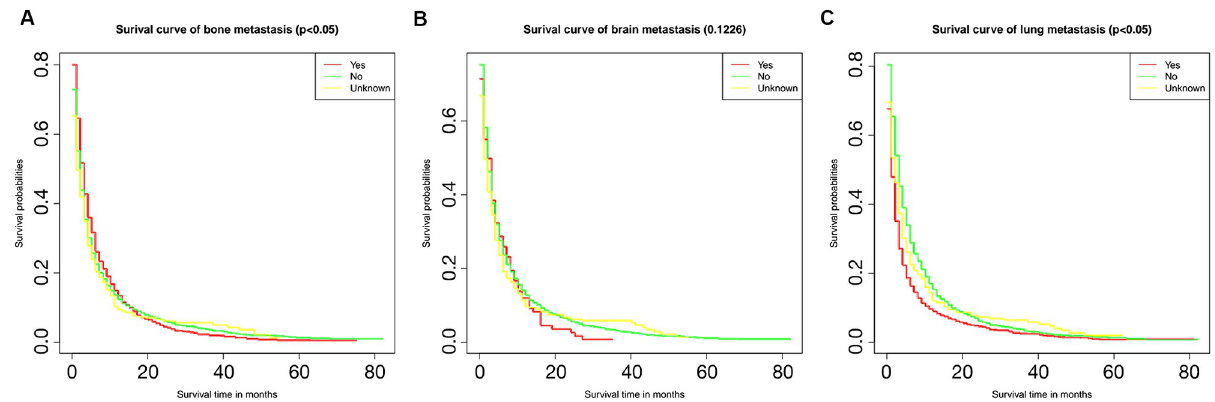
Fig 4. Kaplan-Meier curves among different metastasis status. The Kaplan-Meier survival curves show the differences on survival probabilities among metastasis, non-metastasis and unknown metastasis status at bone (A), brain (B) and lung (C).